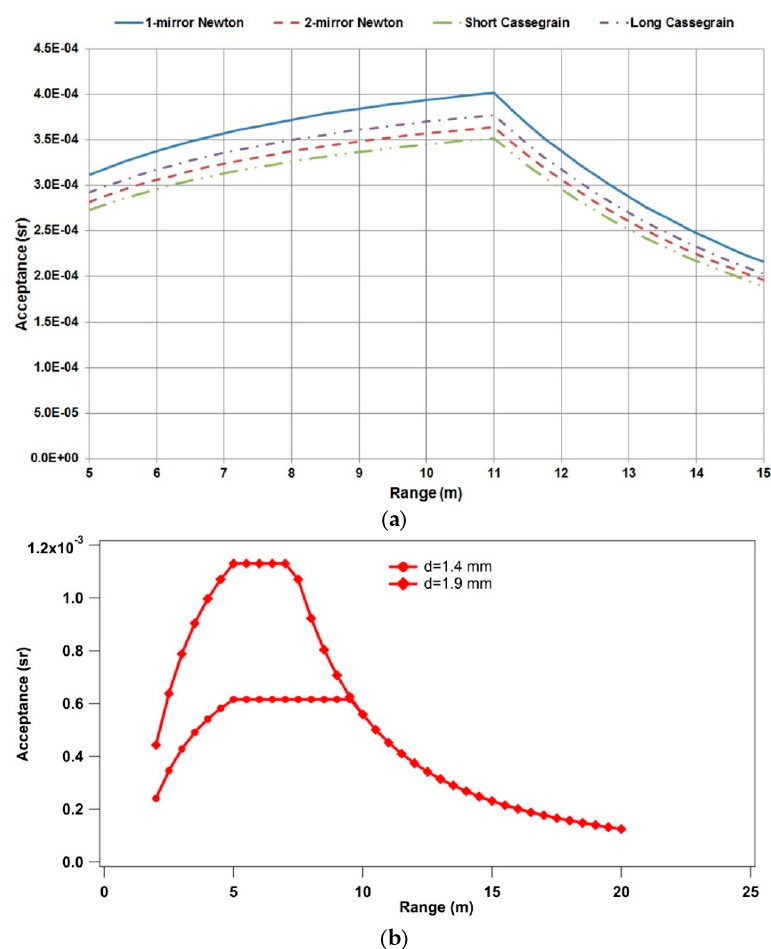
Figure 3. Simulated acceptance (sr) as function of the target-telescope distance for different telescope configurations ( a ); and for 2 fiber bundles with different diameters ( b ).